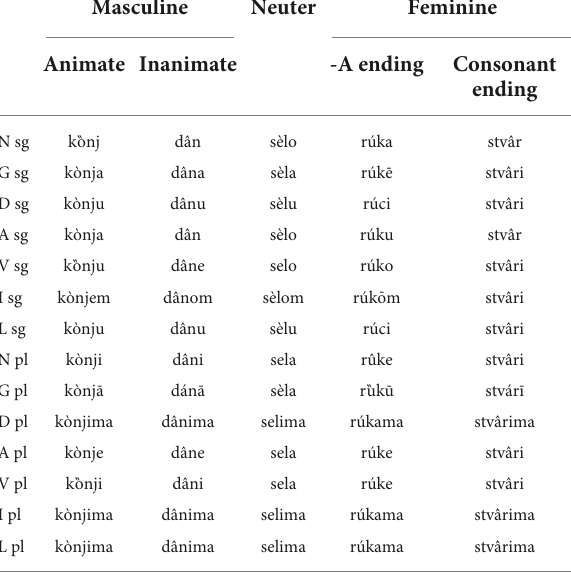
TABLE 2 Examples of Bosnian noun declension, for Masculine, Neuter and Feminine genders, singular and plural forms: “konj” horse; “dan” day; “selo” village; “ruka” hand; and “stvar”